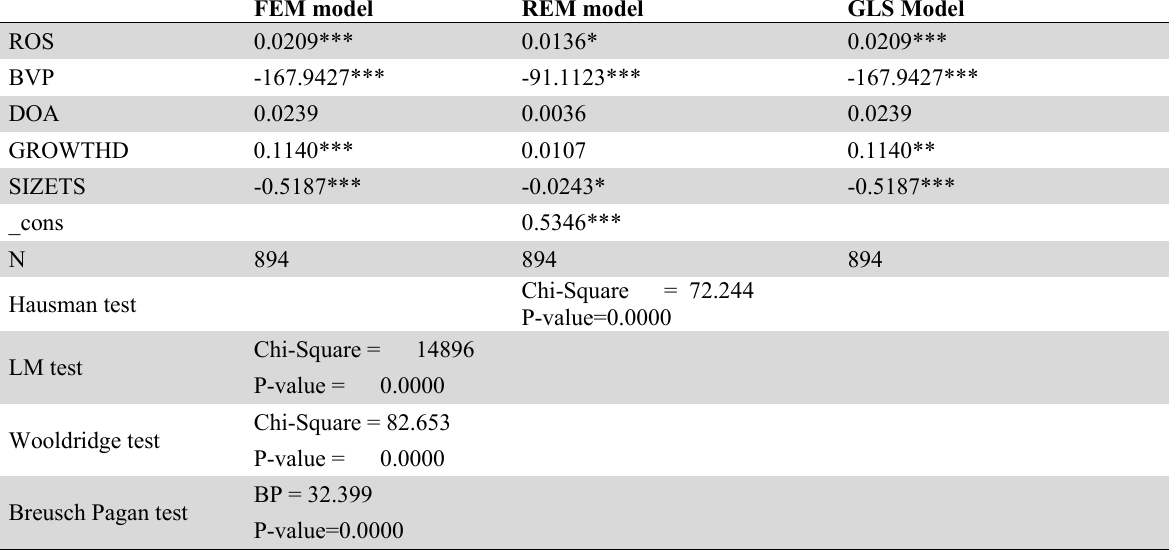
Regression with the profitability variable of